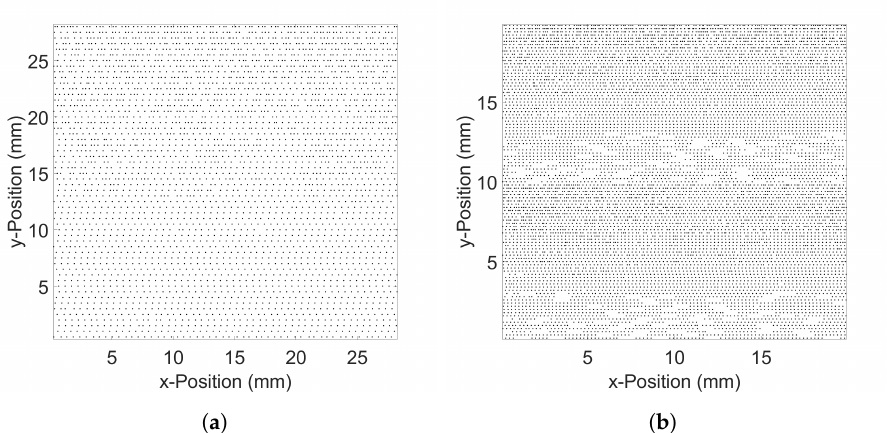
Figure 2. Synchronization using timestamps of TDS and robot: ( a ) a scan speed of 5mm/s and a total scanning time of 6min; ( b ) a scan speed of 2mm/s and a total scanning time of